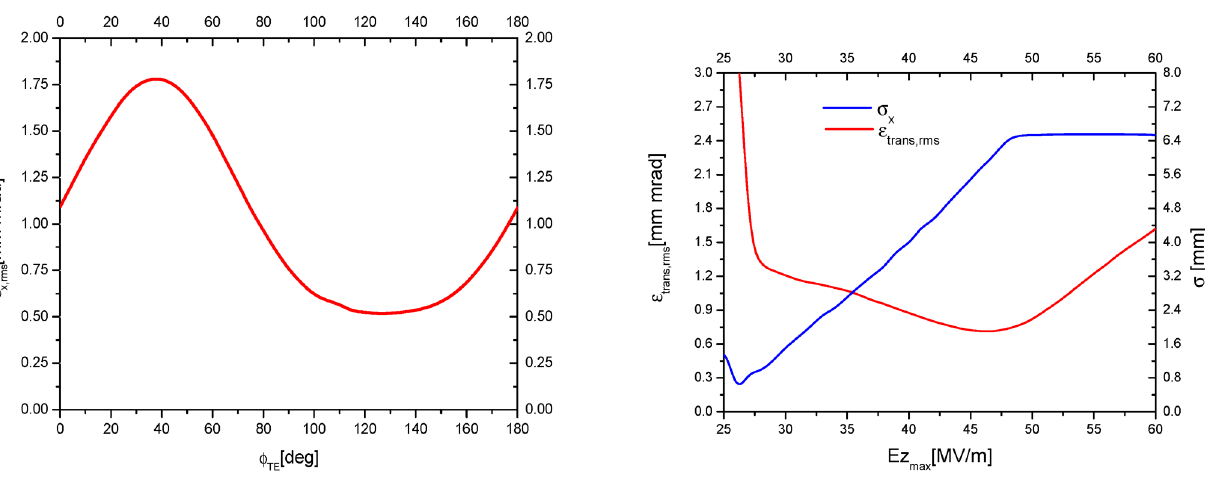
FIG. 6. (Color) Transverse emittance and beam size as a func- tion of the accelerating field amplitude. B max